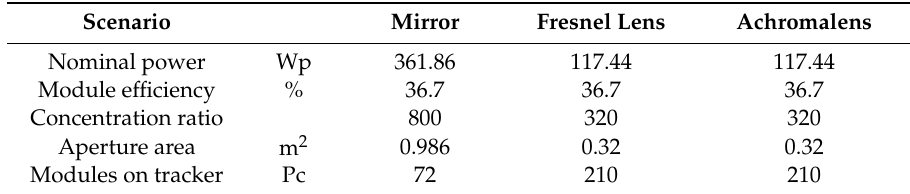
Table 1. Set of parameters for the three HCPV prototypes.